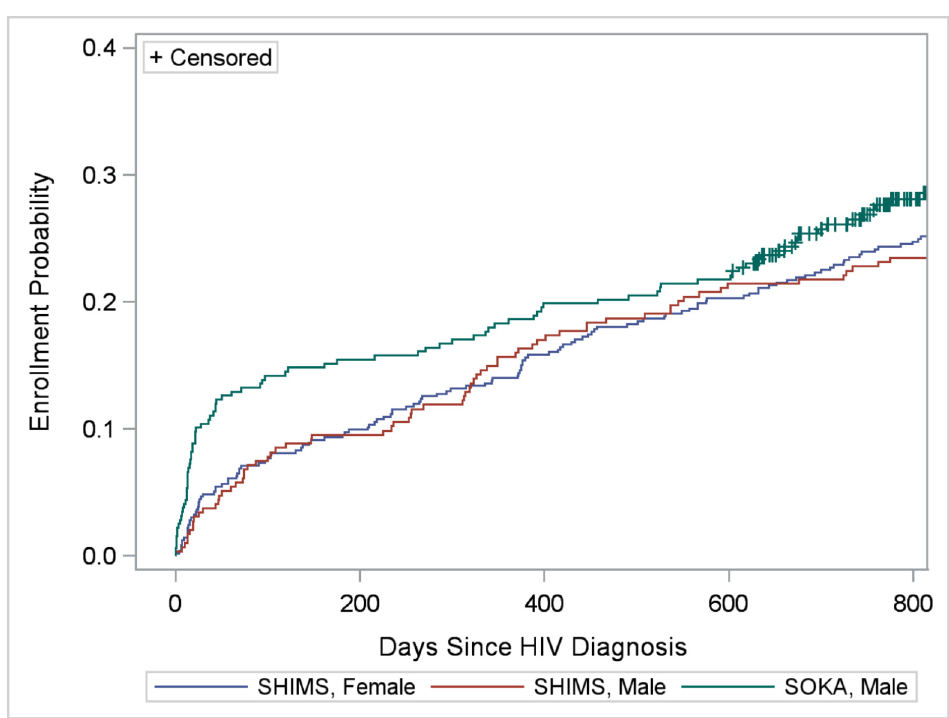
Fig 6. Cumulative verified enrollment in HIV care, by study-gender group. See text for evaluation of differences in functions.